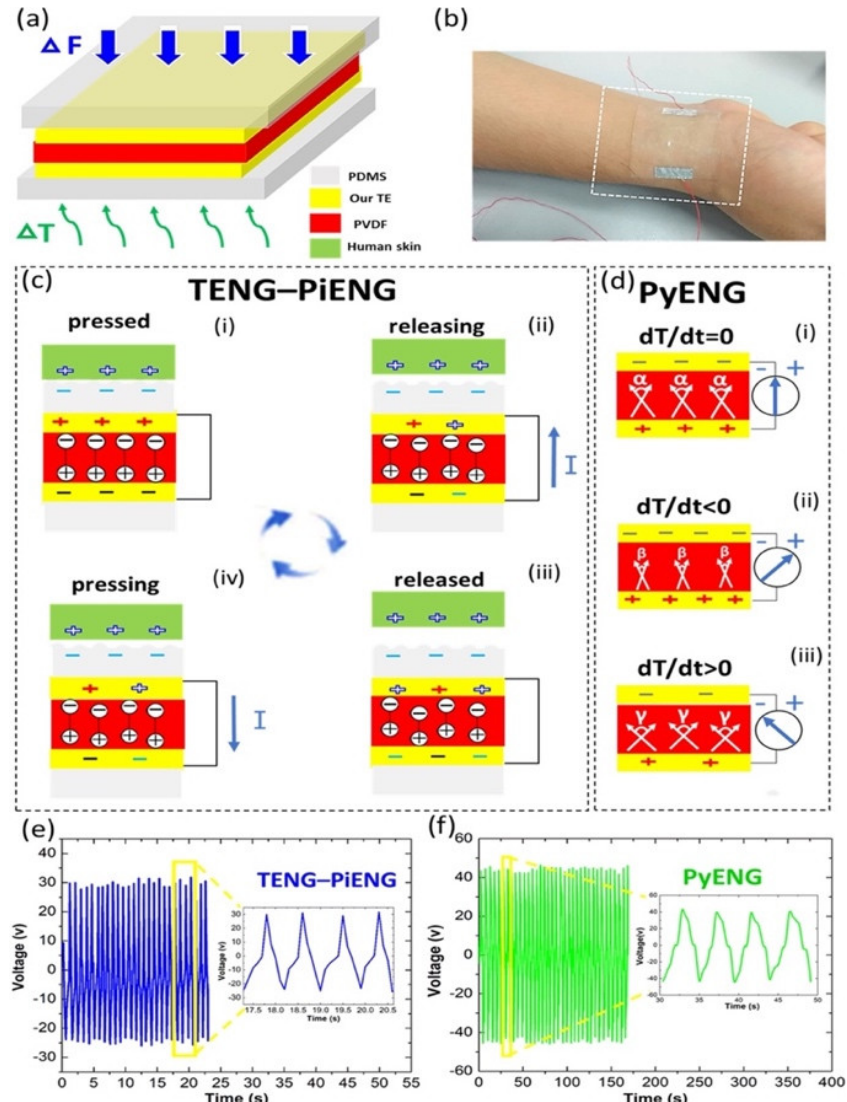
Figure 6. Working mechanism of the flexible hybrid nanogenerator designed by Sun et al. [104]. ( a ) Schematic view of the components of the hybrid nanogenerator. ( b ) Image of the hybrid nanogenerator placed on the wrist. Working mechanism of the ( c ) TENG-PiENG and ( d ) PyENG of the hybrid nanogenerator. Open-circuit voltage of the ( e ) TENG-PiENG and ( f ) PyENG. Reprinted with permission from [104]. Copyright ©2018, Elsevier Ltd.